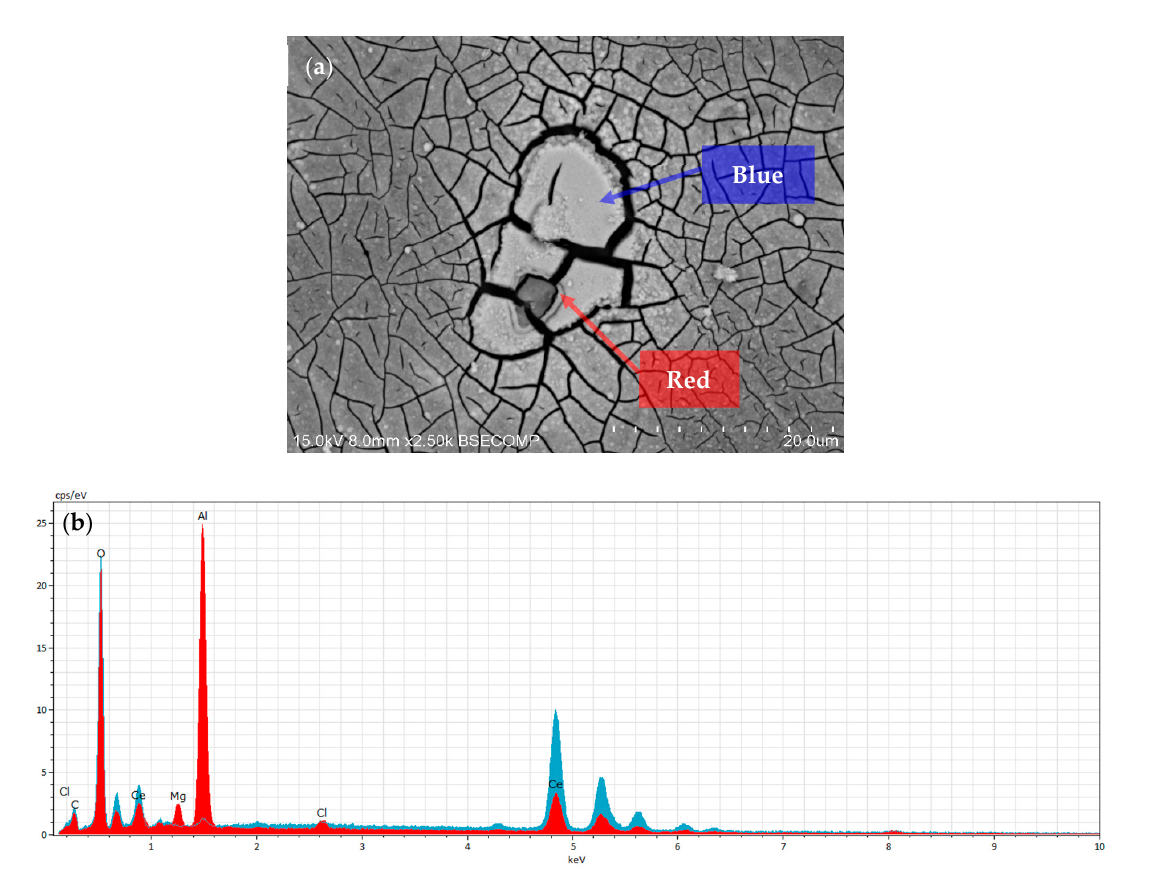
Figure 7. ( a ) SEM image of a cerium island in sample CeCC-1. ( b ) EDX spectra in the central area (red) and in the surrounding area (blue).